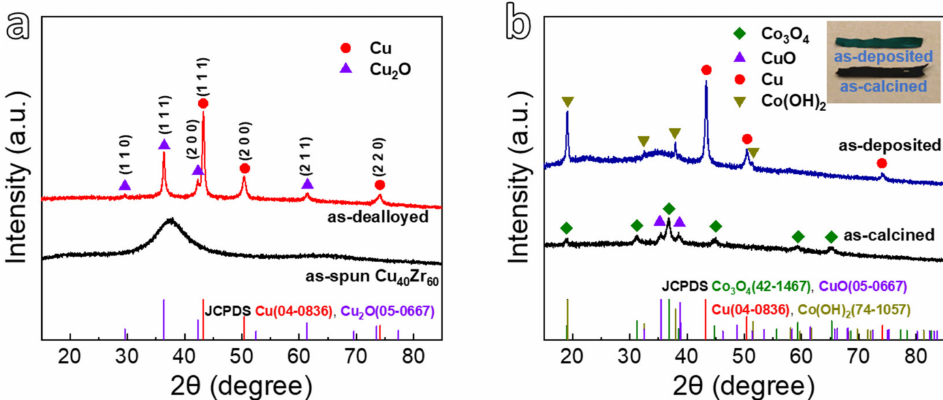
Figure 2. ( a ) XRD patterns of the as-spun Cu 40 Zr 60 ribbon and as-dealloyed sample immersed in 0.05 M HF for 2 h; ( b ) XRD patterns of as-deposited sample immersed in 60 mM Co(NO 3 ) 2 at − 0.8 V for 30 min and as-calcined sample at 573 K for 2